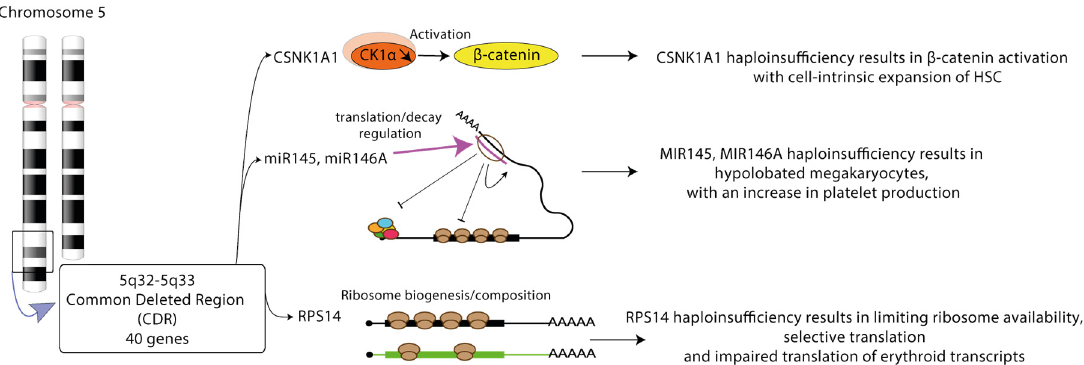
Figure 3. Multiple phenotypic alterations in MDS with 5q deletion. Cell-intrinsic expansion of hematopoietic stem cell (HSC) is a consequence of CSNK1A1 haploinsufficiency. Dysplastic megakaryopoiesis relies on miR145/miR146a haploinsufficiency. Selective translation is a feature of limiting ribosome availability in RPS14 haploinsufficient conditions. CSKN1A1: casein kinase 1A1 gene; CK1a: casein kinase 1a; miR: microRNA; RPS14: ribosomal protein 14.